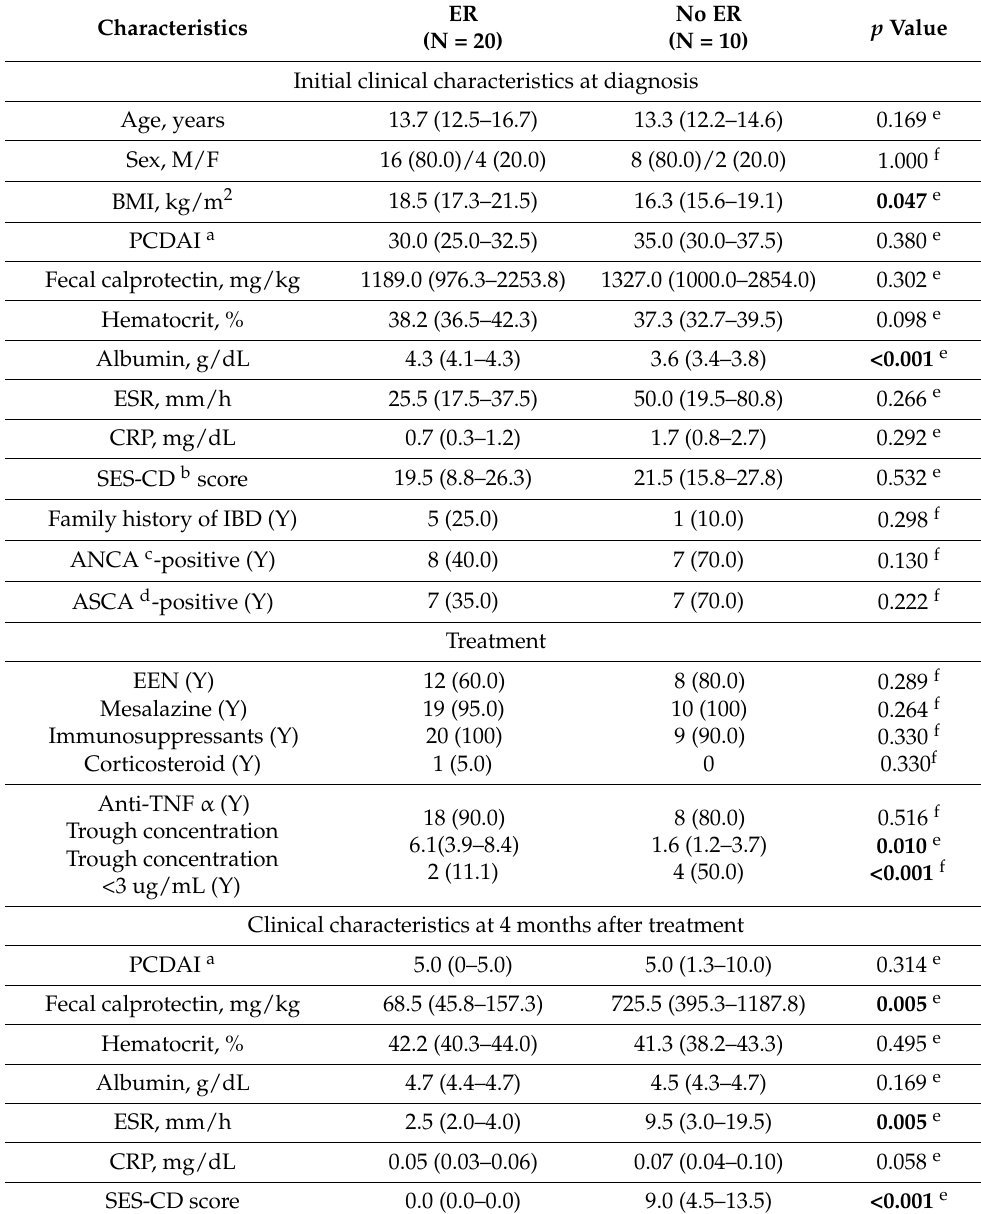
Table 2. At 4 months after treatment, a comparison of initial clinical characteristics and clinical improvement between patients with and without endoscopic remission was made. ER; Endoscopic